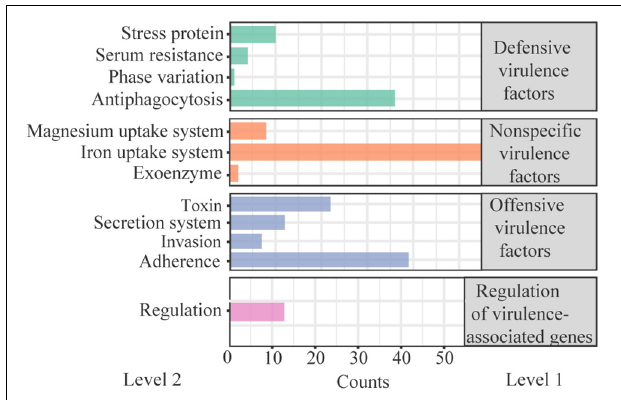
FIGURE 4 | Classification of virulence-related factors (VFs) present in W2 genome. resistance of W2 to erythromycin and ampicillin. Vancomycin resistance genes are not present in W2.